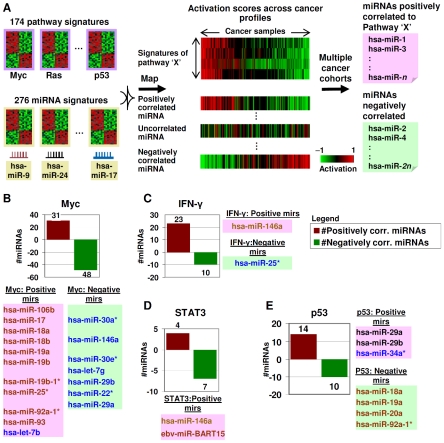
Identifying miRNA–pathway connections.A) Pathway and miRNA gene expression signatures are mapped onto gene expression profiles of samples. For every pathway, positively and negatively correlated miRNAs are identified. This process is repeated across multiple cohorts to identify robust connections. B) miRNA-Myc connections. Positively and negatively correlated miRNAs to Myc are shown in red and green. Correlated miRNAs previously reported as Myc-regulated are highlighted in brown (Myc-induced) and blue (Myc-repressed). C) miRNA-IFN-γ connections. Correlated miRNAs previously reported as connected to IFN-γ are highlighted. D) miRNA-STAT3 connections. Correlated miRNAs previously reported as connected to STAT3 are highlighted. E) miRNA-p53 connections. Correlated miRNAs previously reported as regulated by p53 are highlighted.